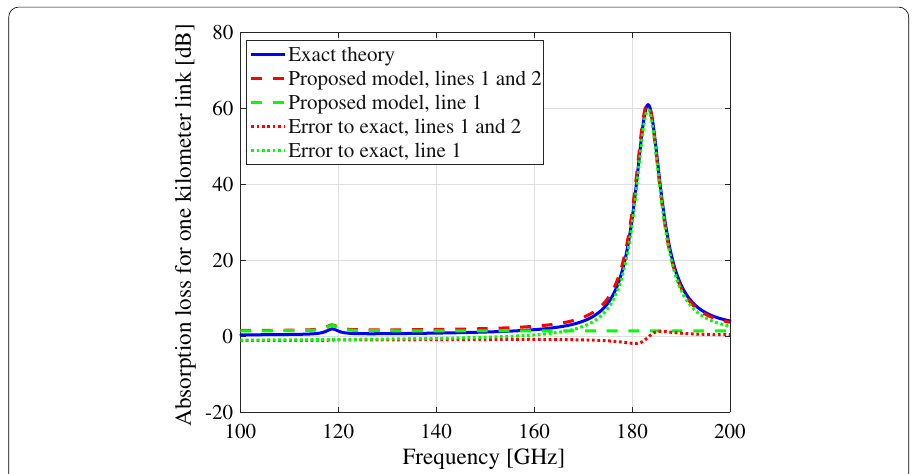
Fig. 6 Performance of the proposed model with reduced terms, low band. Reduced versions of the proposed model giving absorption losses up to about 160 GHz (1 term) and 200 GHz (2